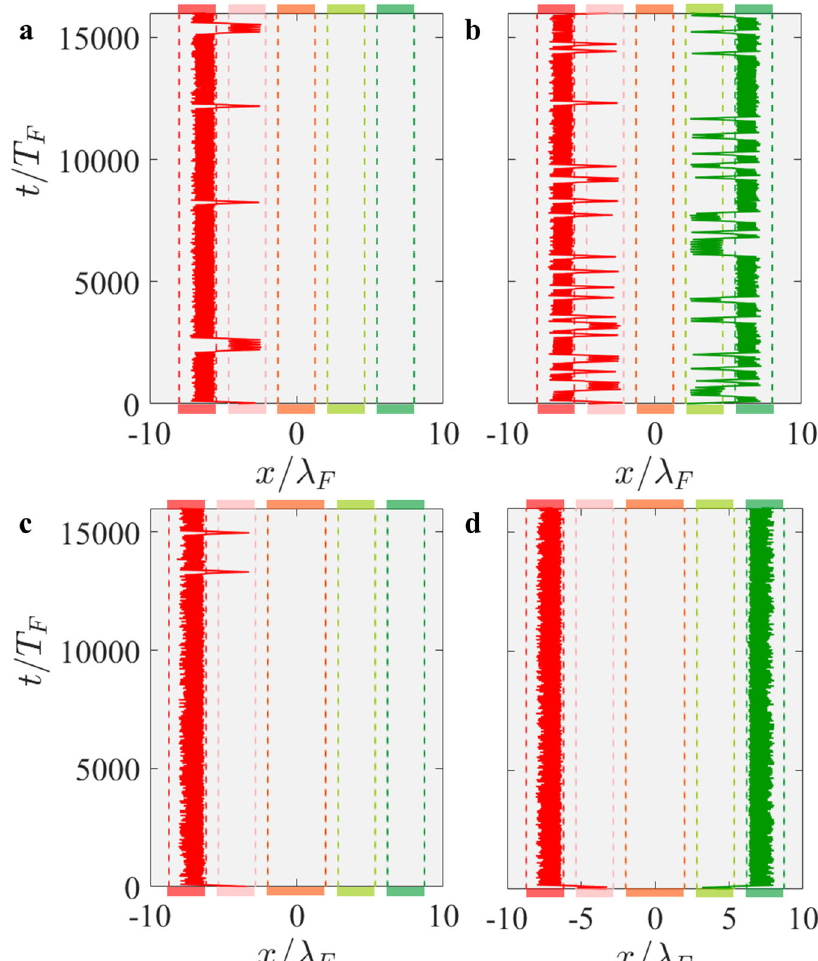
Fig. 2 Tunneling dynamics and trajectories of the drops. a A single droplet tunnels between its ground state (outer cavity) and excited state (inner cavity). The middle cavity (marked in orange) couples the left and right subsystems. The red and green lines denote the particle paths in the left and right subsystems, respectively. Dashed lines indicate the edges of the various cavities. b In the bipartite system, a pair of drops tunnel between their ground and excited states. In ( a , b ), the coupling-cavity length is L c = 2.44 λ F and the four other cavities' lengths are L = 2.52 λ F . Comparing ( a ) and ( b ), makes clear that a single particle ’ s tunneling probability is substantially increased by the presence of a neighboring drop, corresponding to superradiance. The con fi guration shown in ( c , d ) is similar to ( a ) and ( b ) but with a larger coupling cavity L c = 3.96 λ F . Comparing ( c ) and ( d ) reveals that the particle ’ s tunneling between cavities is inhibited by the presence of the neighboring drop, an effect corresponding to